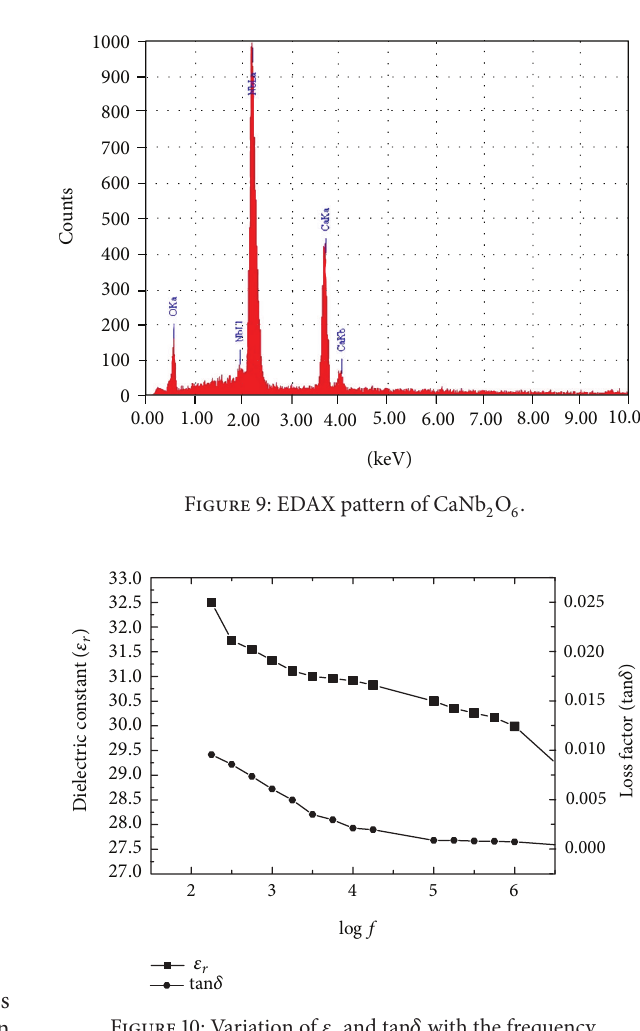
(tan 𝛿 ) of the sintered pellet at 5 MHz are ∼ 29 and 5.3 × 10 −4 , respectively, which indicate that the material is suitable for electronic